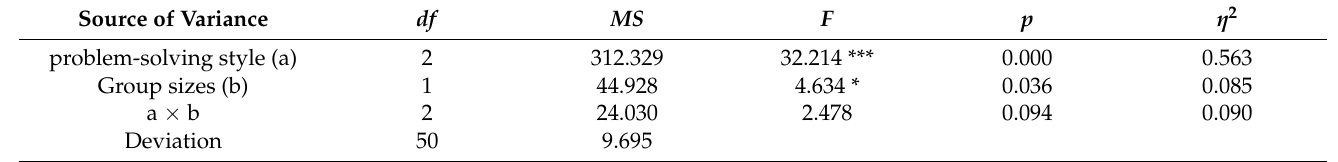
Table 4. Variance analysis of CPS scores under different problem-solving styles and team